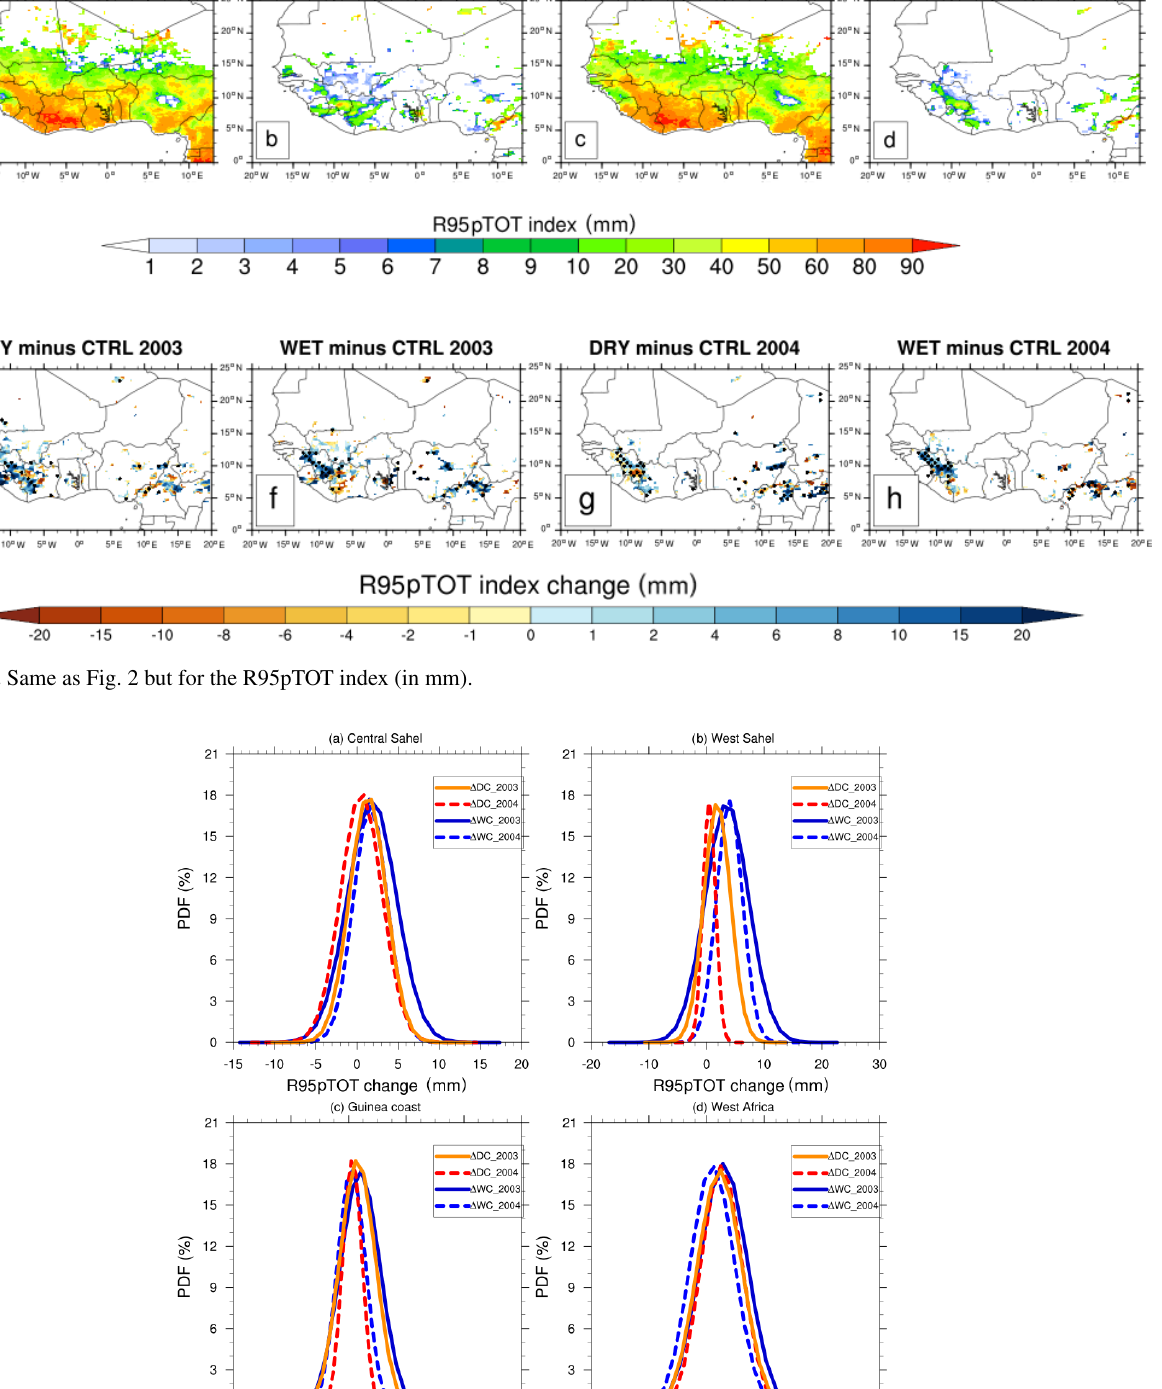
Figure 13. Same as Fig. 3 but for theR95pTOT index (in mm).